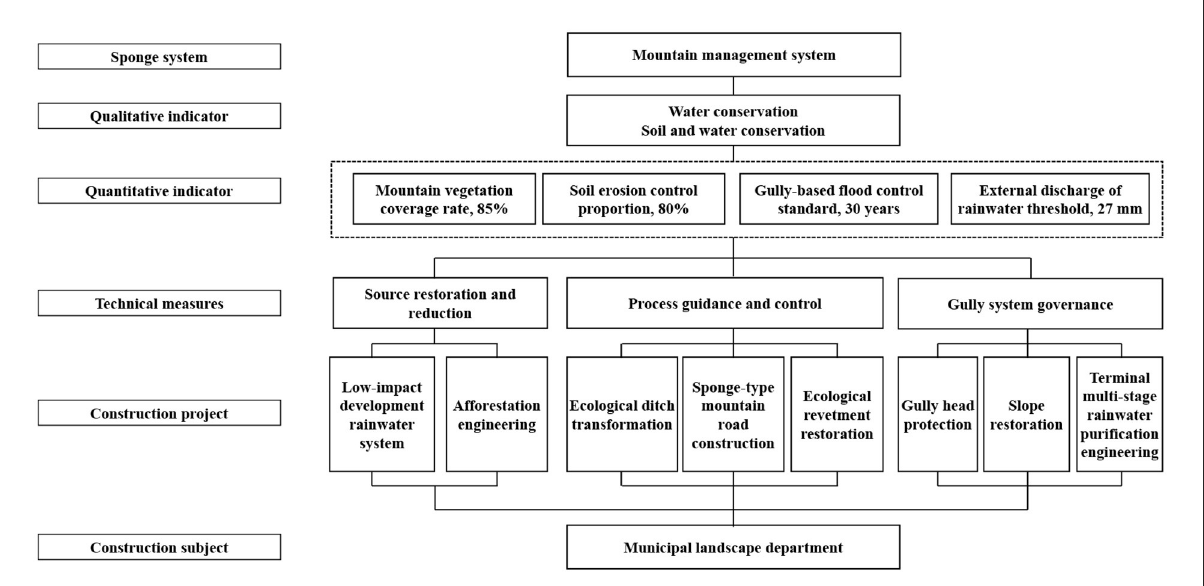
FIGURE8 Sponge system for “mountain management” in